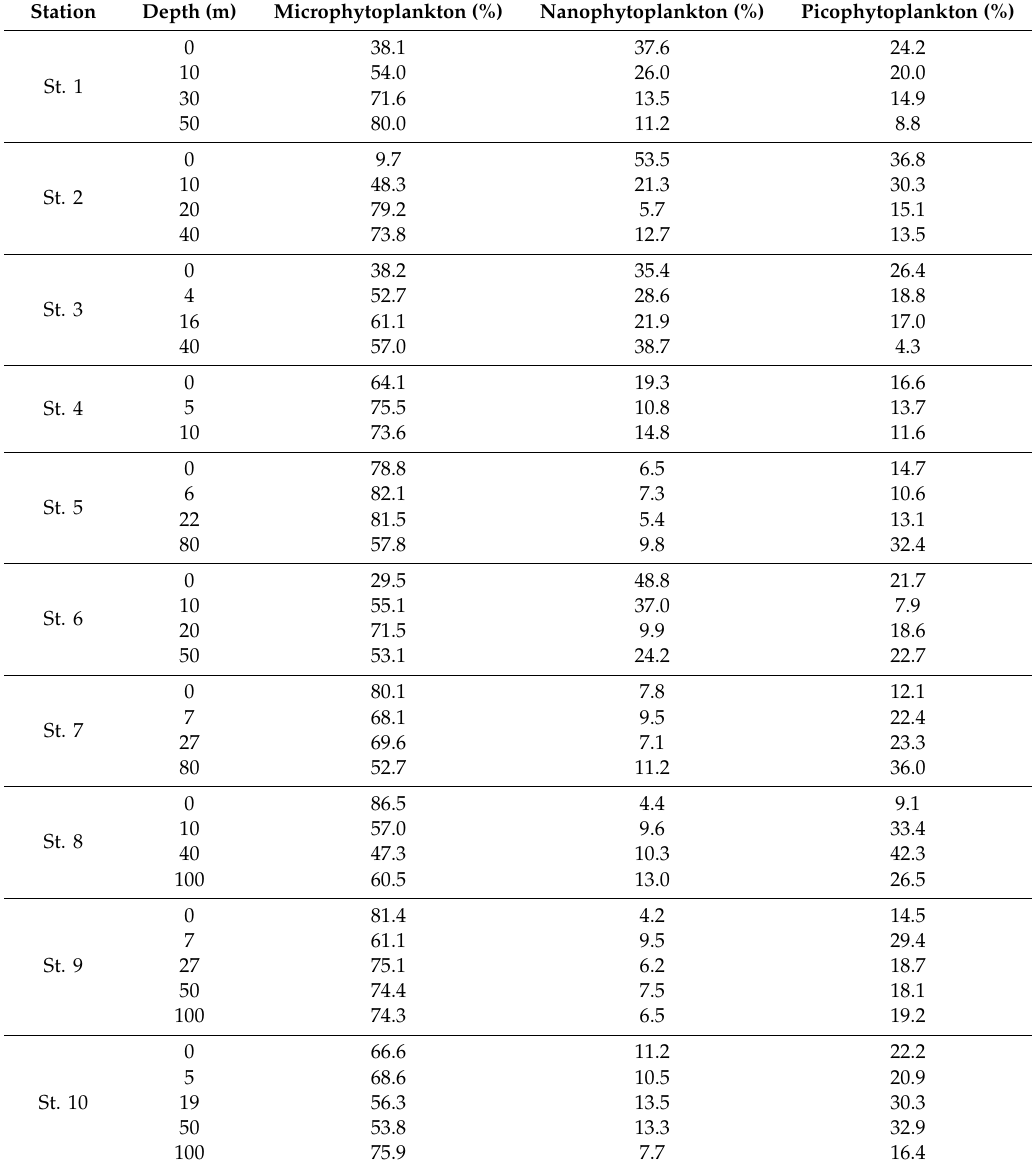
Table 2. The relative contribution of chl-a in the di ff erent size fractions from surface to 100-m depth. Station Depth (m) Microphytoplankton (%) Nanophytoplankton (%) Picophytoplankton (%) St.